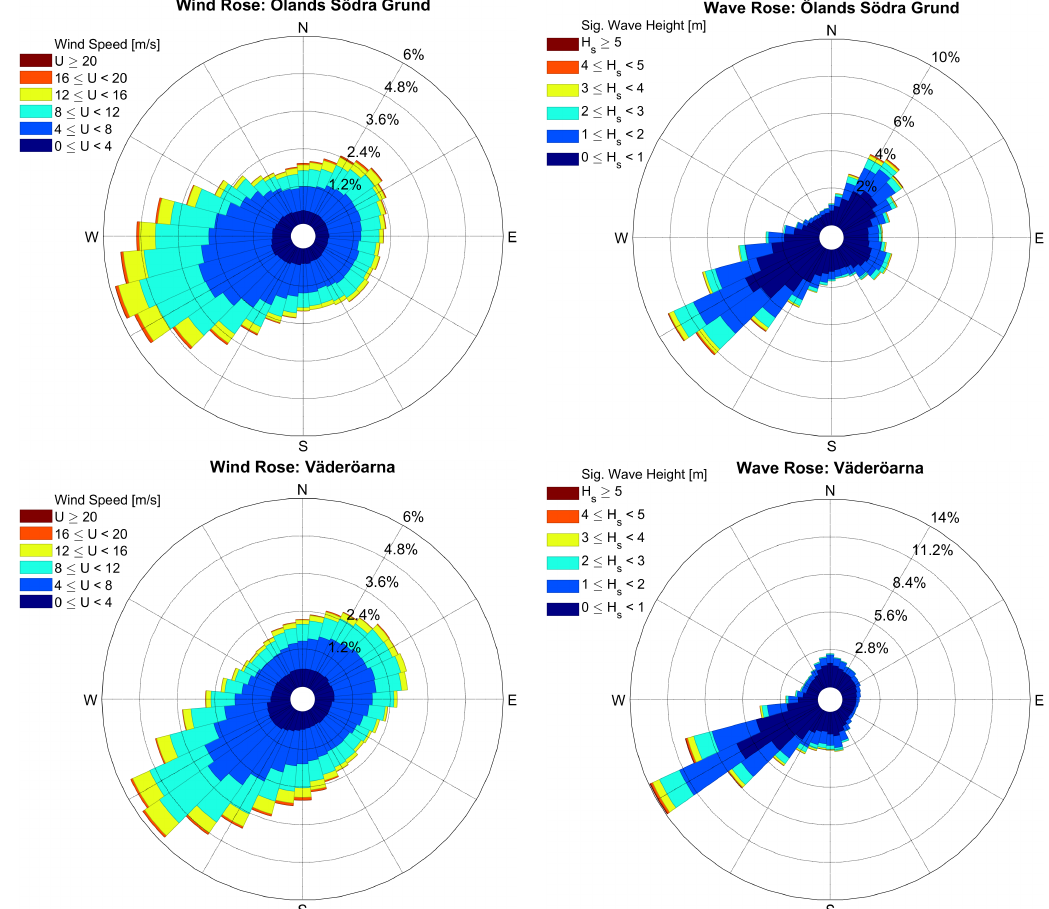
Figure 3. Wind and wave roses at Ölands Södra Grund and